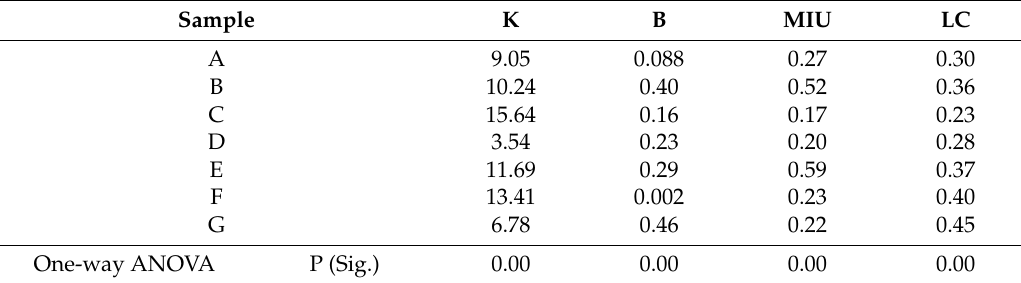
Table 6. KES test results of tactile properties by mean